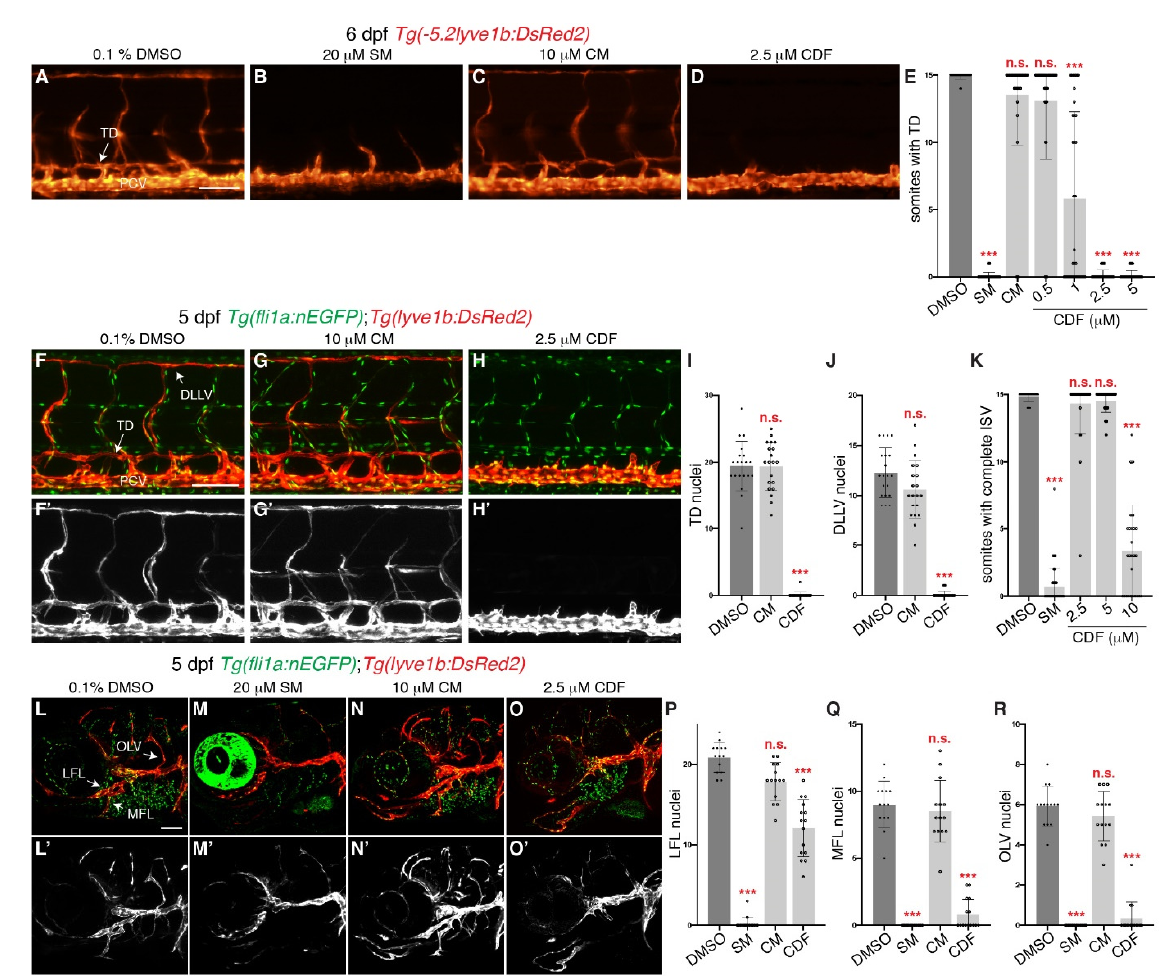
Figure 1. 3,4-Difluorobenzocurcumin treatment inhibits trunk and facial lymphatic development in zebrafish. ( A – D ) Lat- eral fluorescent images of 6 dpf Tg(-5.2lyve1b:DsRed2) larvae treated with either 0.1% DMSO ( A ), 20 μ M sunitinib malate (SM, B ), 10 μ M curcumin (CM, C ), or 2.5 μ M 3,4-Difluorobenzocurcumin (CDF, D ). CDF inhibits lymphatic